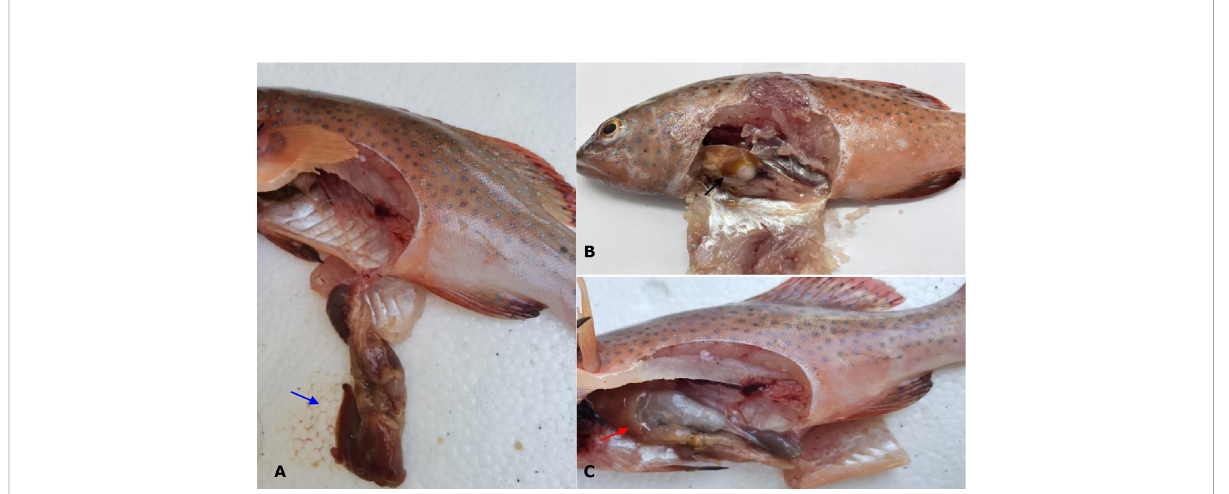
FIGURE 1 Gross signs of diseased coral trout. (A) Healthy fi sh. Blue arrow shows normal liver. (B) Naturally infected fi sh. Black arrow shows necrotic liver. (C) Experimental infected fi sh. Red arrow shows necrotic